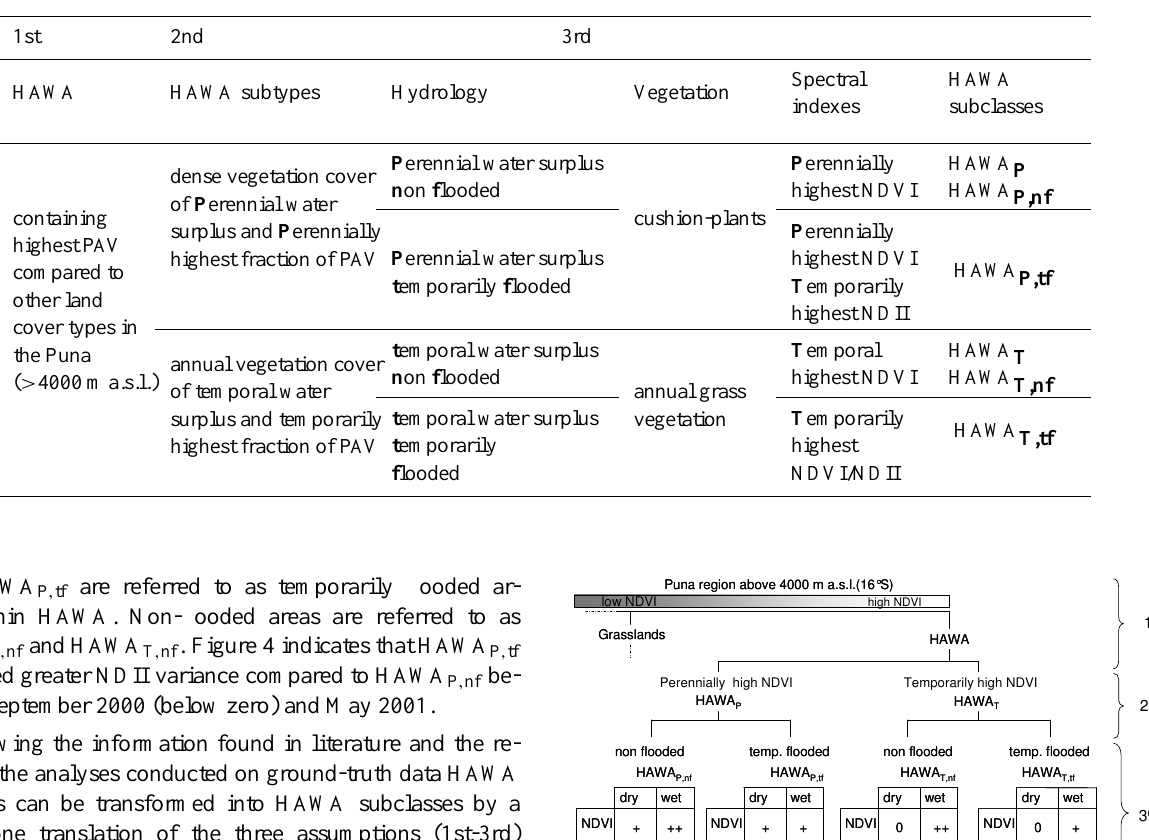
Table 1. Three assumptions (1st–3rd) made based on characteristics in vegetation and hydrologic conditions of HAWA subtypes and derived HAWA subclasses for HAWA mapping based on satellite data as shown in Fig. 4 and introduce into the HAWA-mapping design (Fig. 5). Bold and case-sensitive letters indicate the link between the characteristics of HAWA subtypes and abbreviations used for the HAWA subclasses.